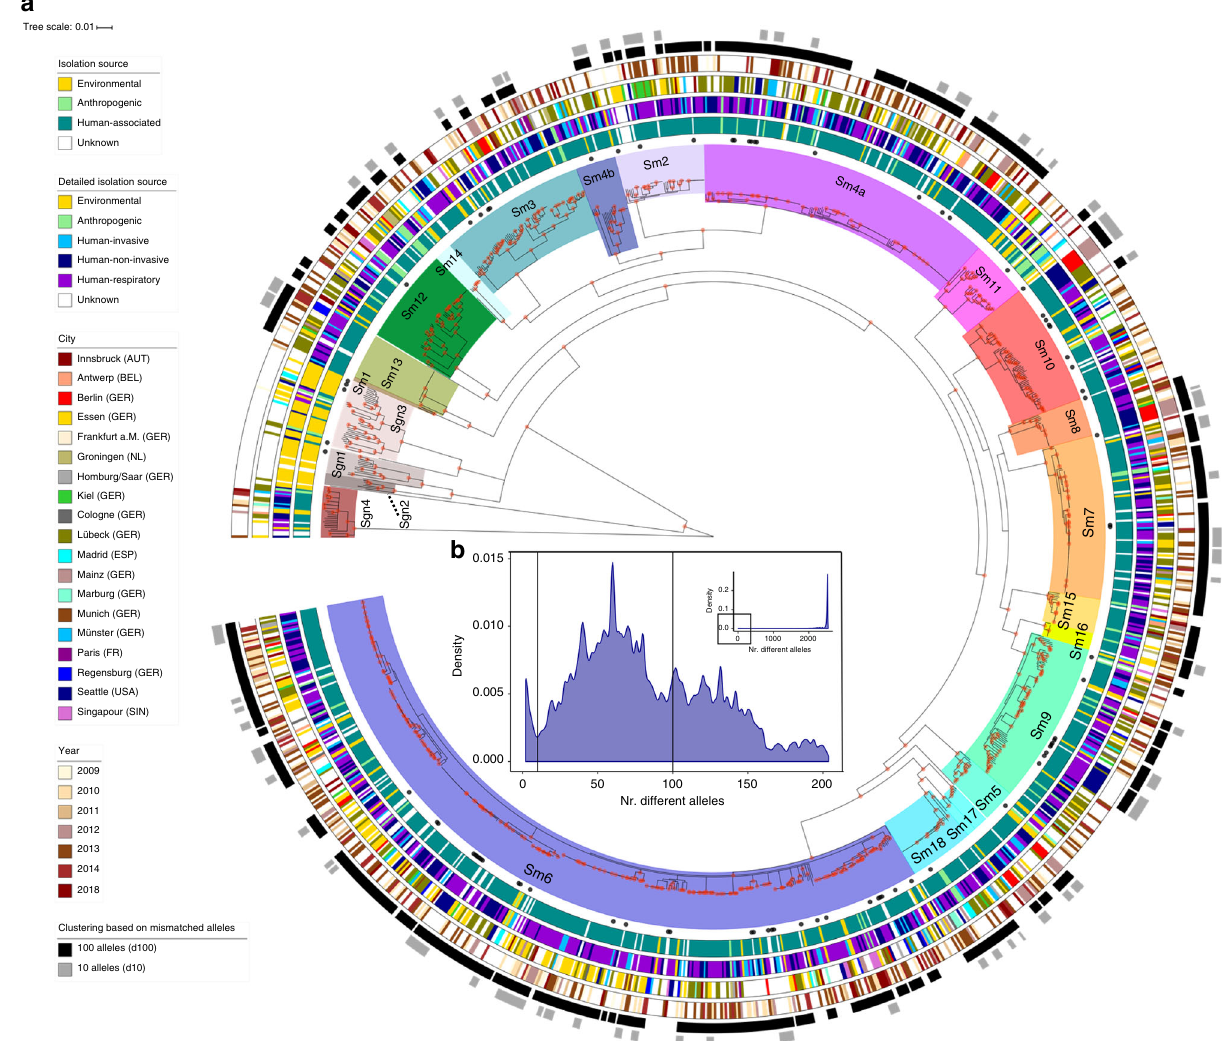
Fig. 4 Spatiotemporal cluster analysis of 1305 S. maltophilia complex strains. a The coloured ranges across the outer nodes and branches indicate the 23 lineages. The black dots indicate the location of the genome data sets used for wgMLST scheme generation. The rings, from inside towards outside denote (i) the isolation source of the strains classi fi ed as either environmental, anthropogenic, human or unknown; (ii) the detailed isolation source of strains similar to the fi rst ring with the human strains subclassi fi ed into human-invasive, human-non-invasive and human-respiratory; (iii) the city of isolation; (iv) the year of isolation (where available), with light colours representing earlier years and darker brown colours more recent isolation dates. The outer rings in black-to-grey indicate the single-linkage-derived clusters based on the number of allelic differences between any two strains for 100 (d100 clusters) and 10 (d10 clusters) allelic mismatches. Red dots on the nodes indicate support values of 100%. b Distribution of the number of wgMLST allelic differences between pairs of strains among the 1305 S. maltophilia strains. The main fi gure shows the frequencies of up to 200 allelic differences, while the inset displays frequencies of all allelic mismatches. Source data are provided as Source Data